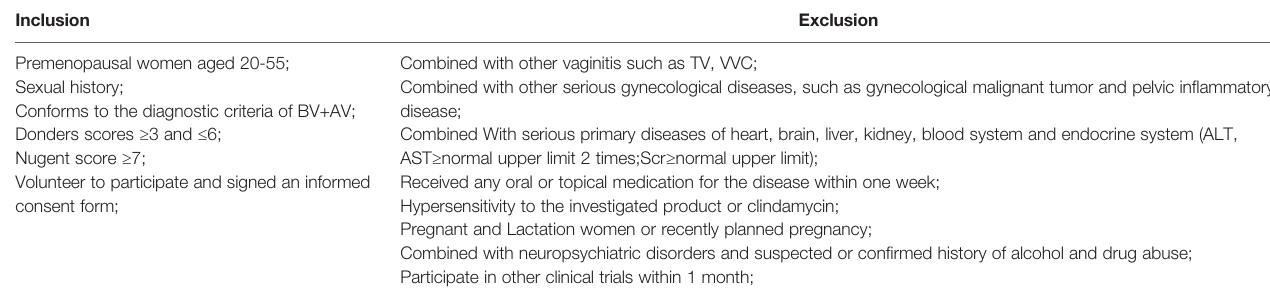
TABLE 1 | Inclusion and exclusion